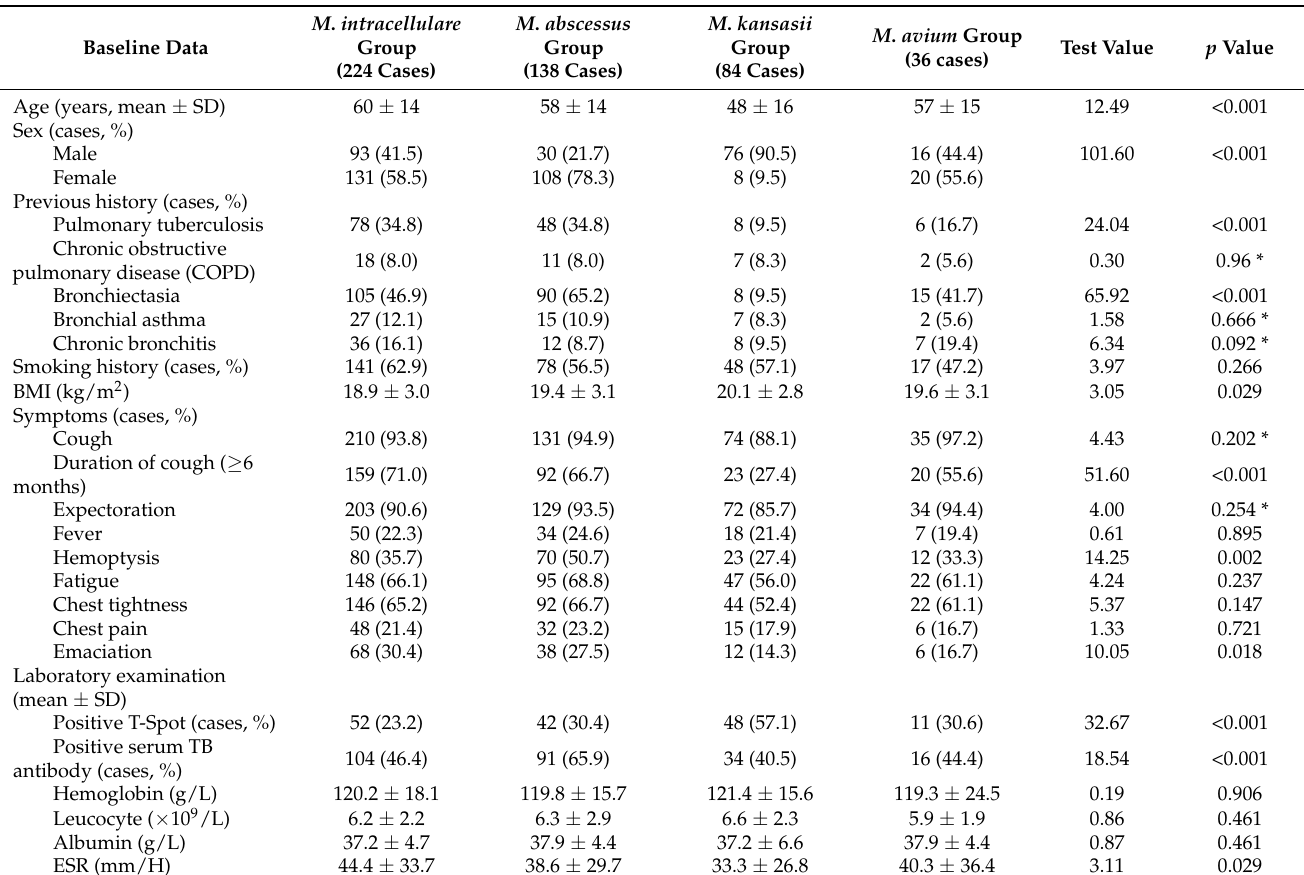
Table 1. Baseline data of patients with NTM pulmonary disease in four